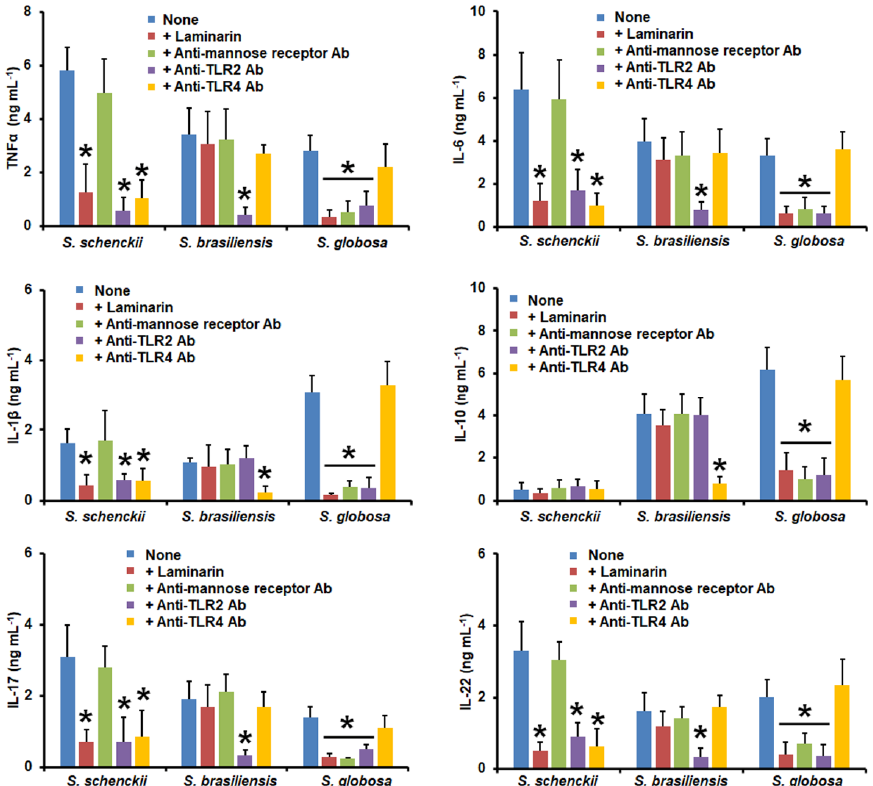
Figure 8. Cytokine production by human peripheral blood mononuclear cells pre-incubated with di ff erent blocking molecules and stimulated with germlings from Sporothrix schenckii , Sporothrix brasiliensis , or Sporothrix globosa . Human peripheral blood mononuclear cells were pre-incubated for 60 min with 200 µg mL − 1 of laminarin, 10 µg mL − 1 of anti-mannose receptor, 10 µg mL − 1 of anti-TLR2, or 10 µg mL − 1 of anti-TLR2, and then challenged with germlings. For tumor necrosis factor-alpha (TNF α ), interleukin 1 β (IL-1 β ), interleukin 6 (IL-6), and interleukin 10 (IL-10), human peripheral blood mononuclear cells were co-incubated for 24 h with live germlings, whilst for interleukin 17 (IL-17) and interleukin 22 (IL-22) stimulation, the human cells were co-incubated with the UV-killed fungal cells. In all cases, the interactions were centrifuged, supernatants collected, and cytokines quanti fi ed by ELISA. Ab—antibody; S. — Sporothrix . None refers to the system where the human cells were pre-incubated only with PBS. Results are the median ± standard deviation from data generated with samples from eight donors, analyzed in duplicate. * p < 0.05 when compared with the cytokine level stimulated by PBS-pre-incubated cells.